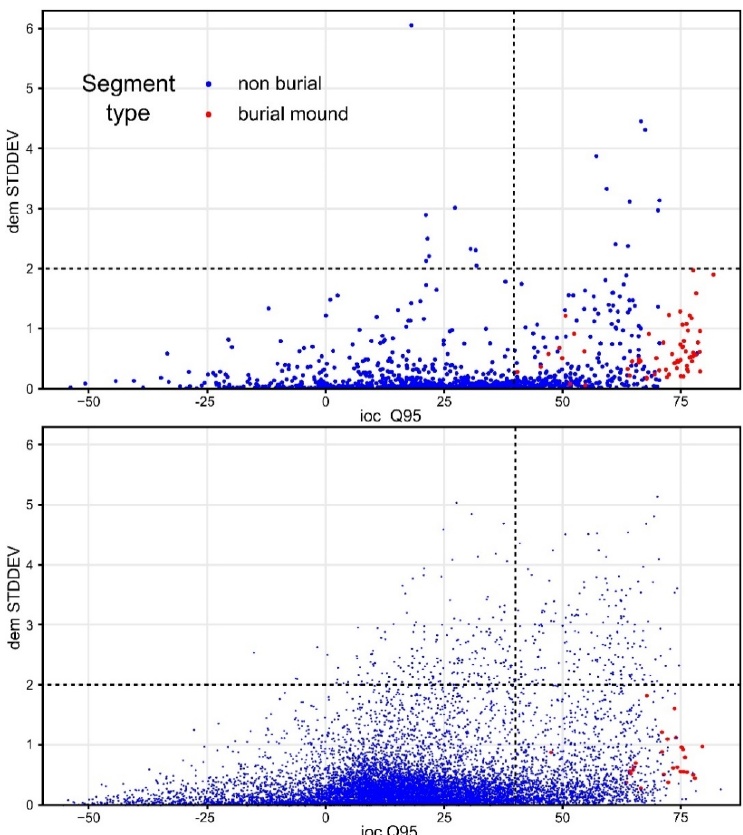
Figure 15. The training ( top ) and the validation ( bottom ) datasets distribution in the feature space of the two most important variables. (a high-resolution version can be found at https: // doi.org / 10.6084 / m9.figshare.11798688.v1).